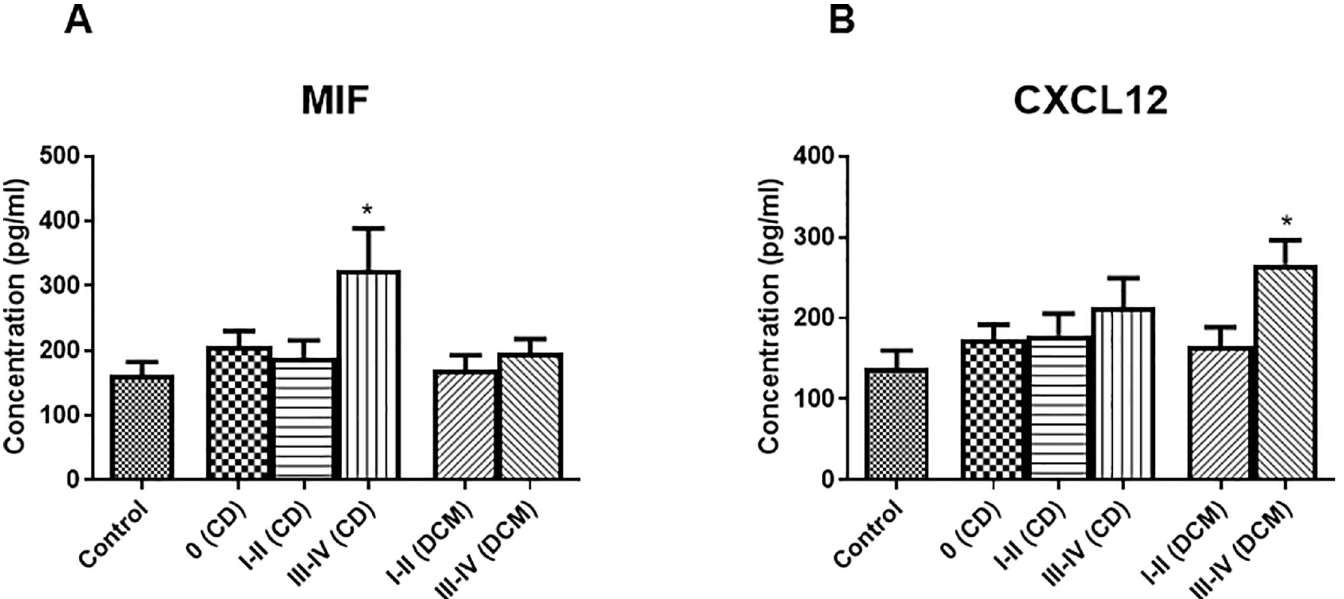
Fig 1. A. Plasma concentration of MIF in controls (n = 25); in patients with CD distributed in asymptomatic (0) (n = 46), NYHA classes I-II (n = 24), and NYHA classes III-IV (n = 23); and in patients with DCM divided in NYHA classes I-II (n = 22) and NYHA classes III-IV (n = 26). Data is given as mean ± SEM. � p < 0.05 vs control. B. Plasma concentration of CXCL12 in controls (n = 21); in patients with CD distributed in asymptomatic (0) (n = 44), NYHA classes I-II (n = 25), and NYHA classes III-IV (n = 23); and in patients with DCM divided in NYHA classes I-II (n = 22) and NYHA classes III-IV (n = 26). Data is given as mean ± SEM. � p < 0.05 vs control.